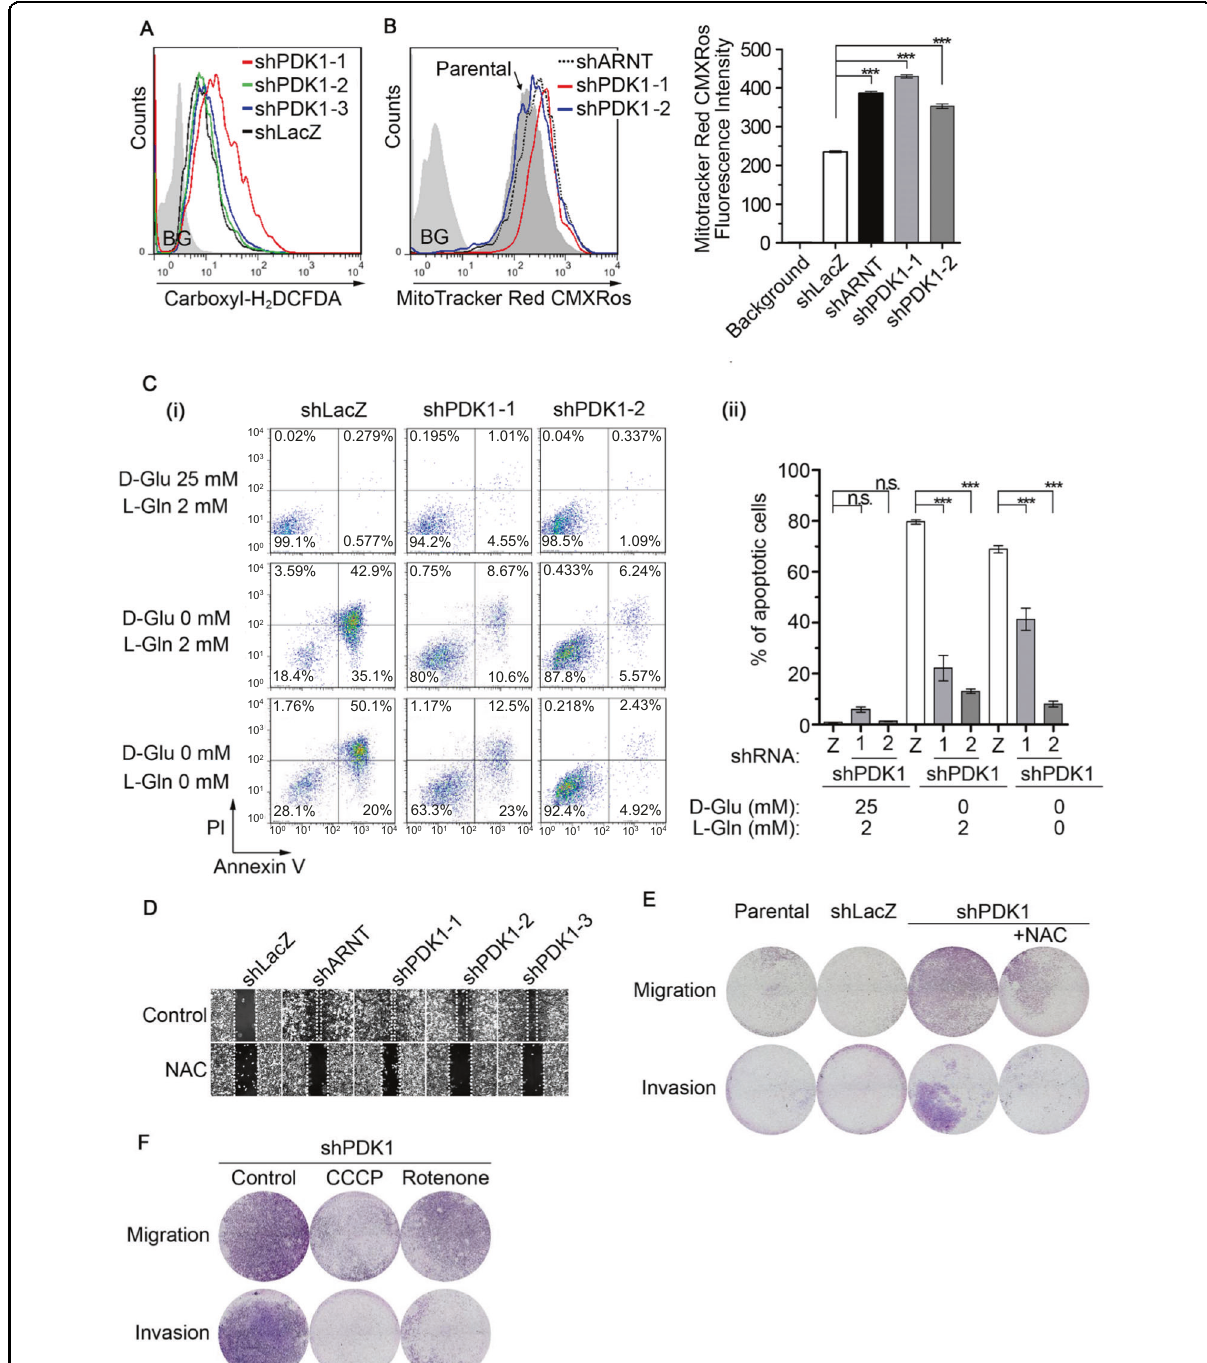
Fig. 6 The knockdown of PDK1 enhances ROS levels, glucose independence, and cell migration and invasion. A – B A375 cells were incubated with Carboxyl-H 2 DCFDA or Mitotracker Red CMXRos for 30 min and then signals were detected by fl ow-cytometry to evaluate the ROS levels and mitochondrial membrane potential. The fl uorescence intensity of Mitotracker Red CMXRos from individual cells was statistically analyzed by Prism 6.0 software ( B ). C Cells were cultured in DMEM with the indicated concentration of D-glucose and L-glutamine for 48 h. Total cells were harvested and stained with Annexin V (1:40) and Propidium Iodide (1:1000). The fl uorescence intensity of Annexin V and Propidium Iodide were evaluated by fl ow-cytometry. (i). The percentage of apoptotic cells were statistically analyzed by Prism 6.0 software (ii). D – F A375 cells were treated with NAC (20 mM), CCCP (10 μ M) and rotenone (1 μ M) for overnight. The migration and invasion properties of cells were analyzed by wound-healing, trans-well migration and invasion assays as described in the “ Materials and methods ”